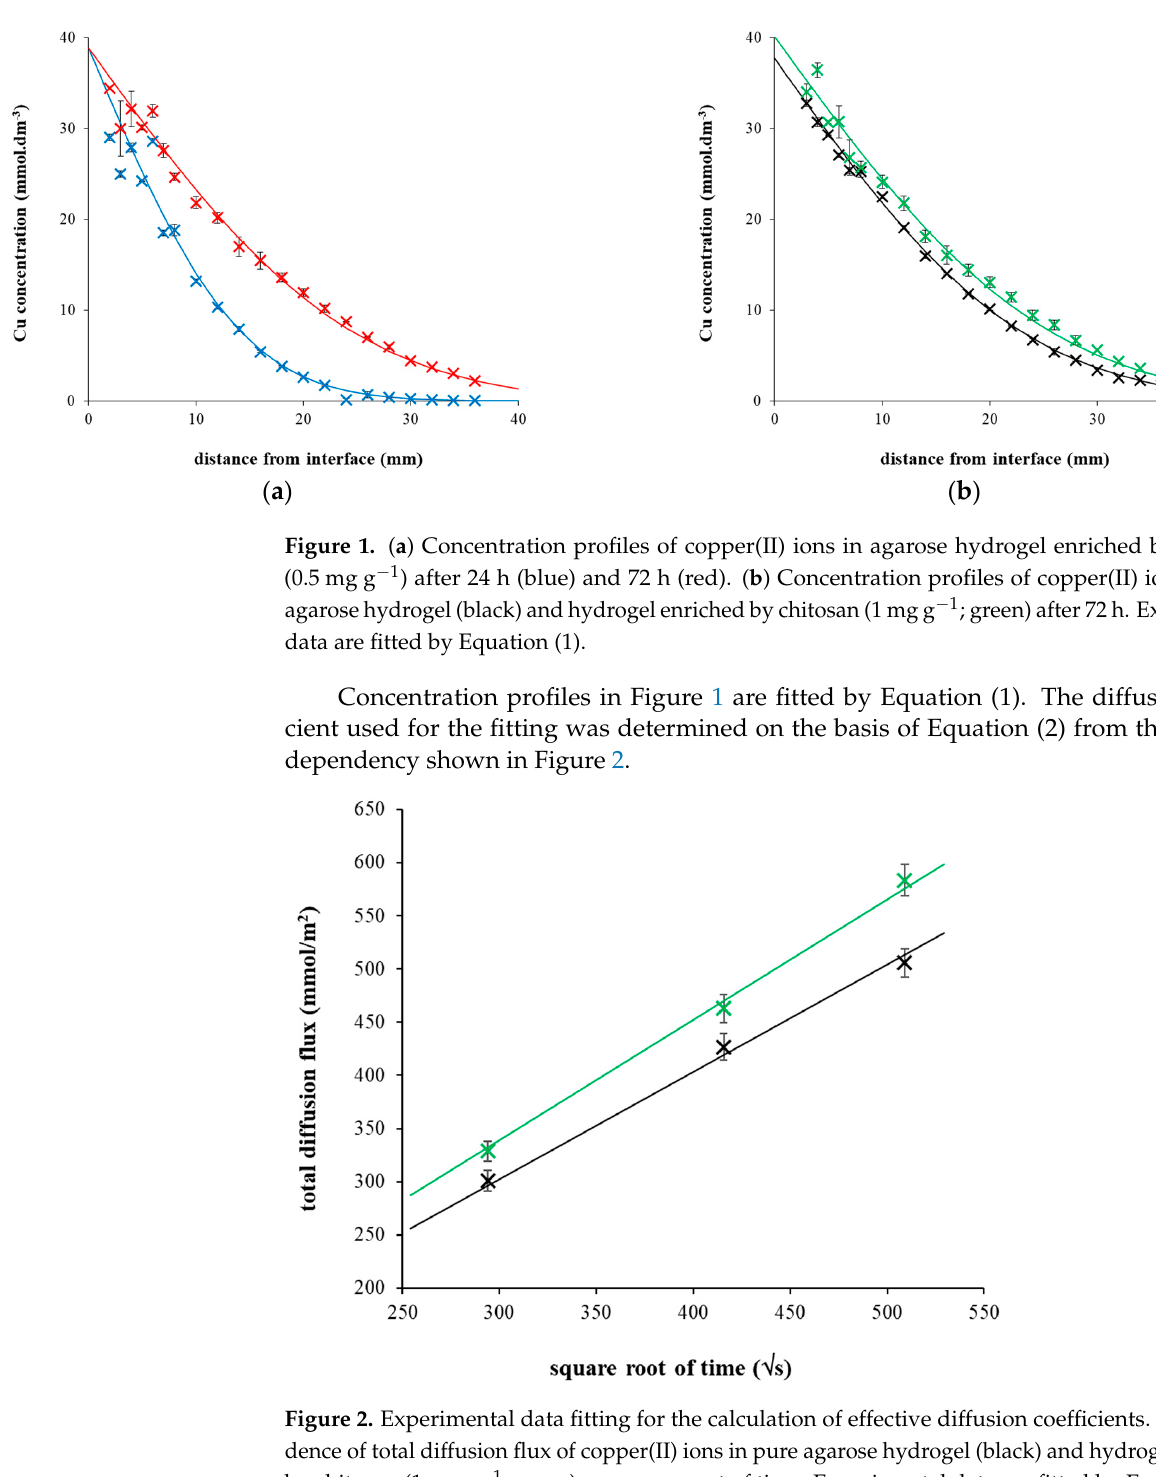
Figure 2. Experimental data fitting for the calculation of effective diffusion coefficients. The depend ‐ ence of total diffusion flux of copper(II) ions in pure agarose hydrogel (black) and hydrogel enriched by chitosan (1 mg g − 1 ; green) on square root of time. Experimental data are fitted by Equation (2). The diffusion coefficient D h is valid for the diffusion in non-reactive hydrogel and its value is affected by the pore structure of hydrogel. If the particles diffuse in hydrogel, their motion is influenced by size of pore volume accessible for the diffusion. It can be expressed as the porosity ϕ ; meaning that a portion of free volume joins the bulk volume of hydrogel. The diffusion in pores, which are not straight, also requires a longer diffusion path in comparison with the diffusion in homogeneous medium as, e.g., water